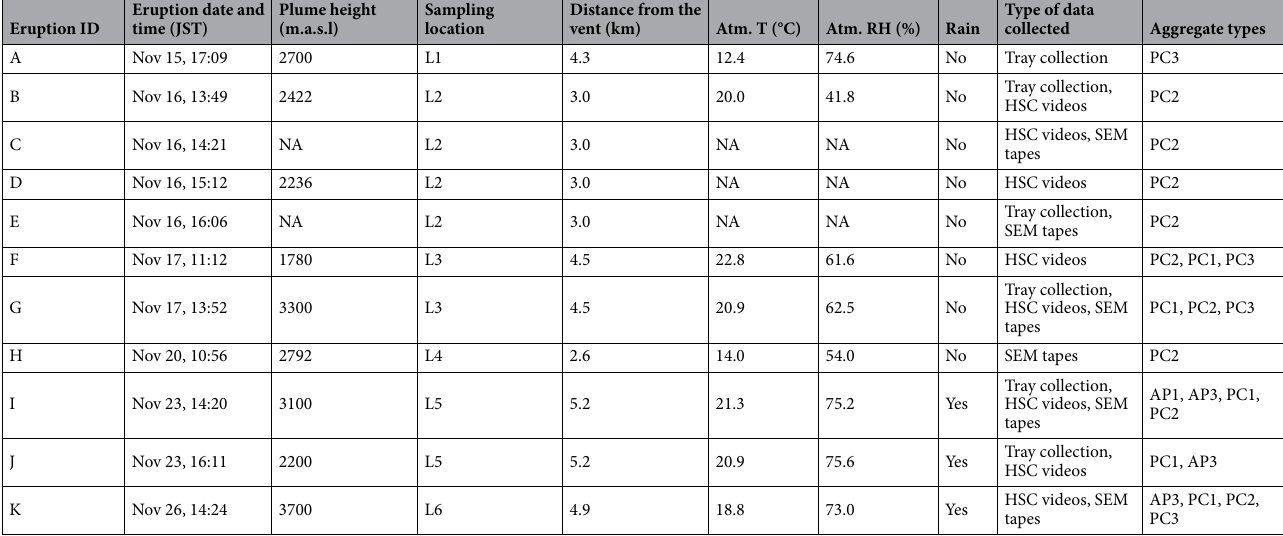
Table 1. Sampling locations, time of eruptions given in JST (offset UTC + 9:00 h), eruptive conditions and meteorological conditions; NA indicates not available. Information on the type of data collected and types of aggregates identified is also provided. RH indicates Relative Humidity. Plume height (in meters above sea level) was extracted both from the dataset published by the Japan Meteorological Agency and from High-Definition videos (see “Methods” section for more details); some plume height information is missing due to bad weather